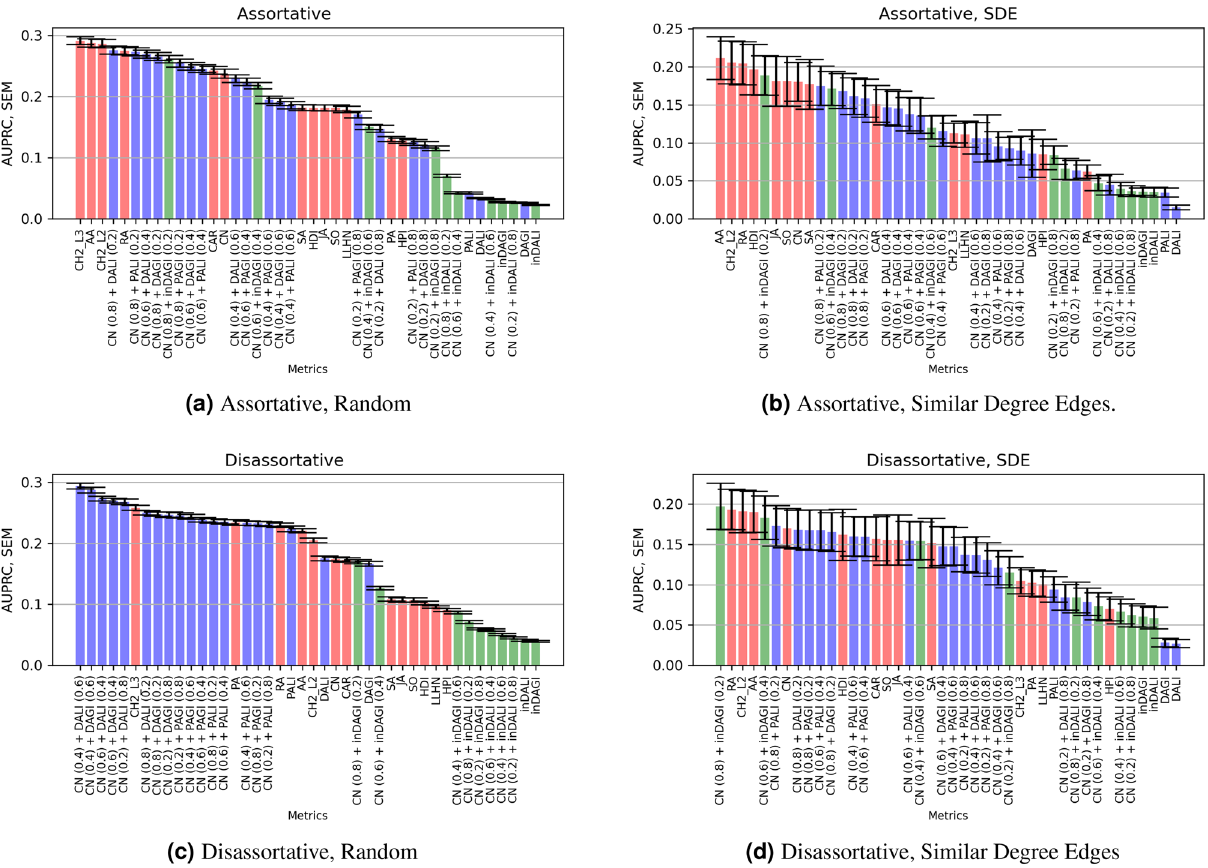
Figure 4. Performance of the LP models (i.e., the AUPRC values) implemented on the standard networks using random edges sampling ( a , c ), descending Similar Degree Edges ( b , d ). Assortative networks are shown in ( a , b ), and disassortative networks are shown in ( c , d ). Refer to Table 1 for details on the assortativity group each standard network belongs to. Red bars refer to standard LP models, blue bars refer to dissimilarity-based metrics along with their extensions and green bars refer to similarity-based metrics along with their